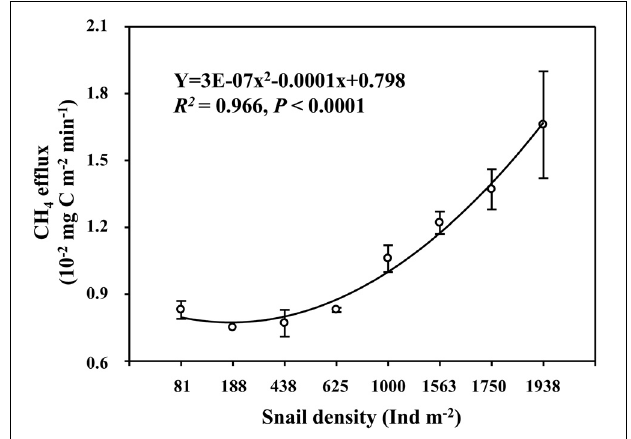
FIGURE 1 | Relationship between snail density and CH 4 efflux in Poyang Lake. Vertical bars denote standard errors of means ( n = 3).